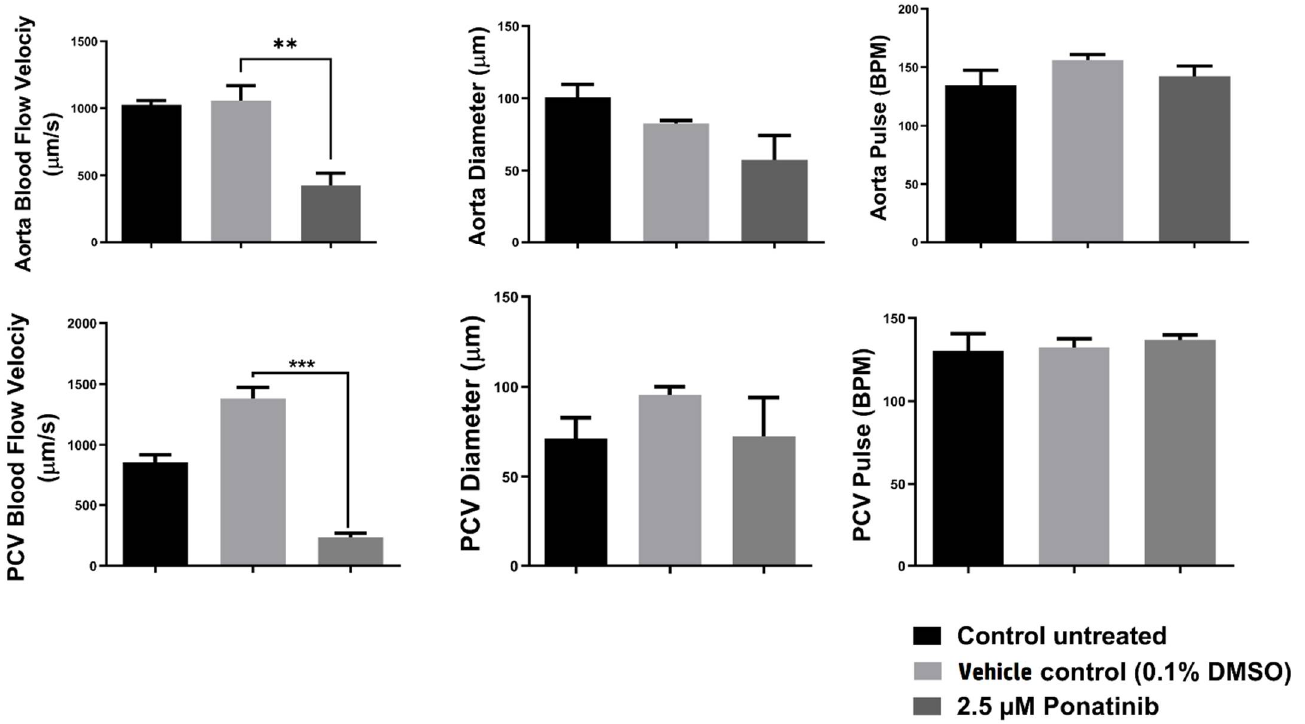
Figure 2. Cardiac function assessment and blood flow analysis for Ponatinib-tested embryos. Measurement of cardiac function for treated groups with Ponatinib at 72 hpf in comparison to the control untreated group (embryos were kept in egg water only) and the vehicle control group (0.1% DMSO in egg water); DMSO is the vehicle in which the Ponatinib drug was dissolved. All data are presented as mean ± SEM (6 embryos were used in each group; the experiment was performed in triplicate). D’Agostino and Pearson omnibus normality test was performed on all data to determine distribution. All parameters passed the test. Accordingly, a one-way-ANOVA with Sidak posthoc test was performed to compare pair: control vs. negative control and negative control and 2.5 μM Ponatinib. (**) = p < 0.01, (***) = p <